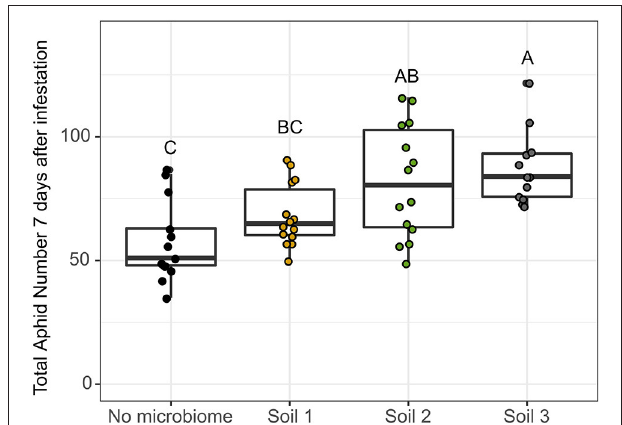
FIGURE 6 | Native soil microbial community has a “bottom-up” impact on aphid performance after 7 days of infestation. Aphid performance was measured as the total number of aphids present on the plant 7 days after infestation with ten adult, wingless aphids. “No microbiome” control refers to pre-sterilized soil with no introduced native microbial community. Differing letters indicate significant differences between groups at p < 0.05 with Tukey’s Honest Significant Differences test.